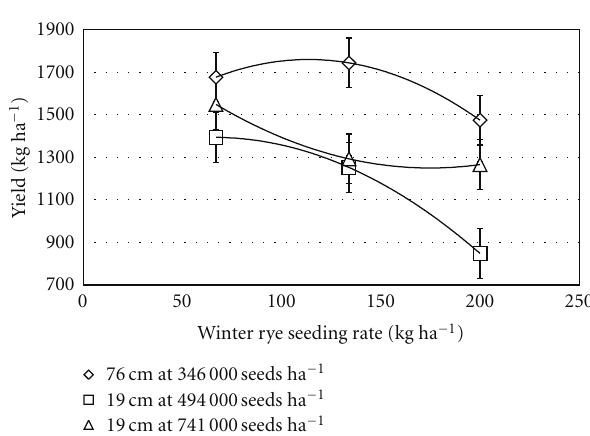
a Abbreviations: NS: nonsignificant. b Winter rye emerged in the spring and died over the summer as in other research [6].